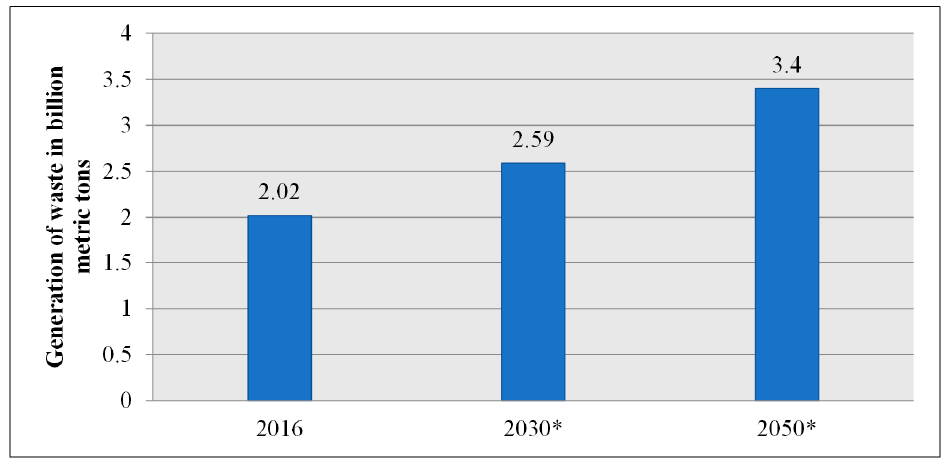
Figure 2. Worldwide municipal solid waste generation planning (2016–2050) [15]. *: Prediction values.